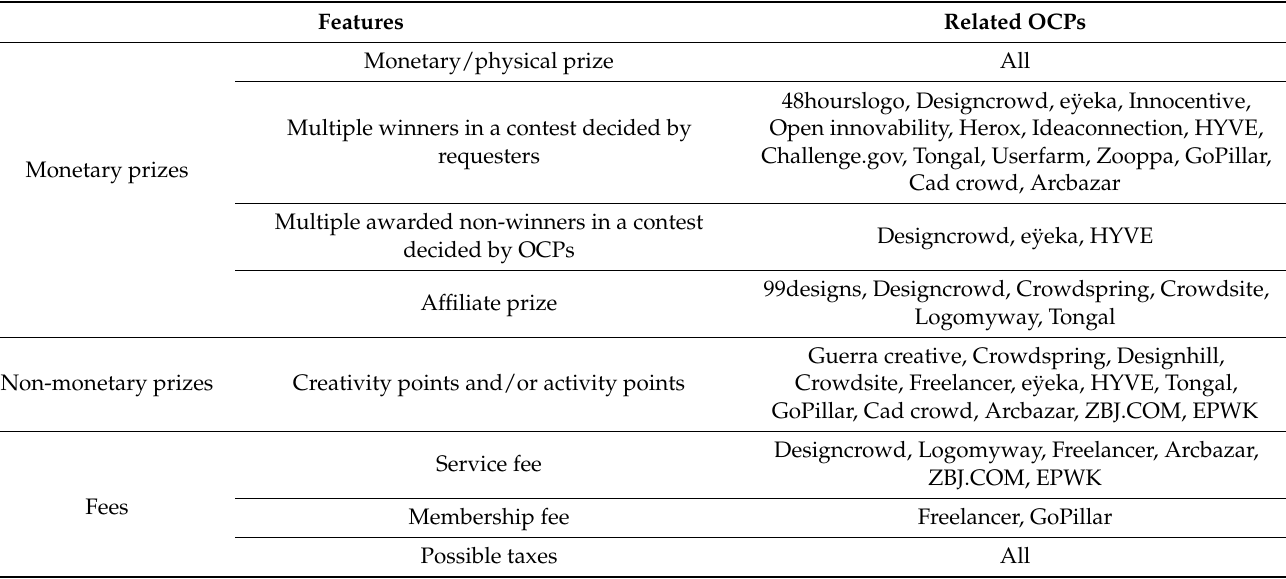
Table 3. Prizes and fees defined by the